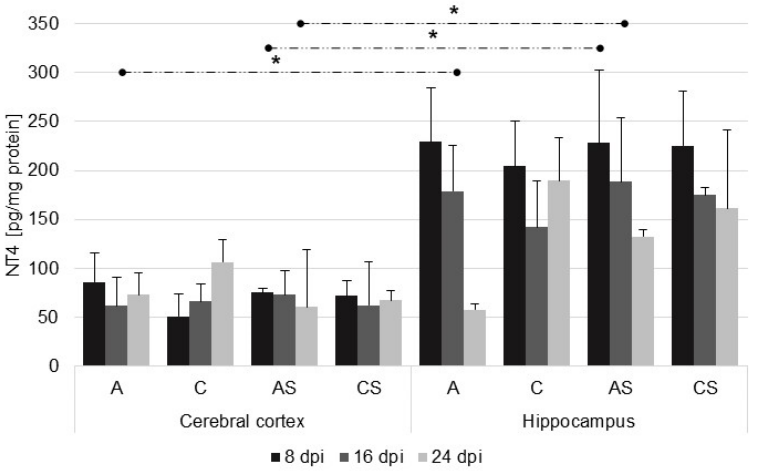
Figure 4. Neurotrophin-4 level (pg/mg protein) in the cerebral cortex and hippocampus in control and infected groups at 8, 16, and 24 days after Acanthamoeba spp. infection (dpi). Data present means ± SD for 6 independent experiments. C, immunocompetent uninfected mice; CS, immunosuppressed uninfected mice; A, immunocompetent Acanthamoeba spp. infected mice; AS, immunosuppressed Acanthamoeba spp. infected mice; dashed arrows indicate differences between brain structures; * p ≤ 0.05 for the significance of difference (Mann–Whitney U test).